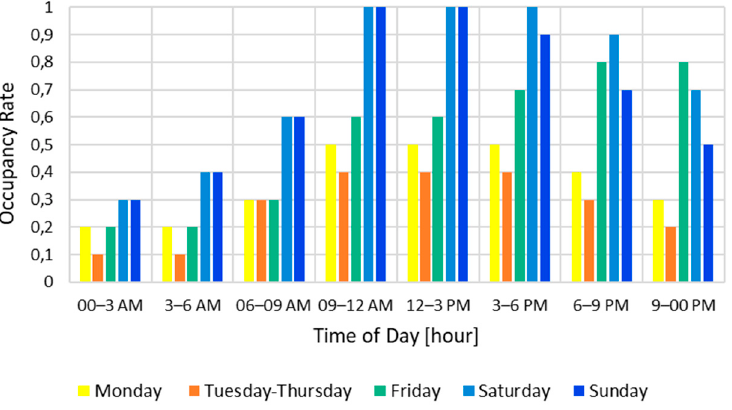
Figure 11. Occupancy rate in the peak